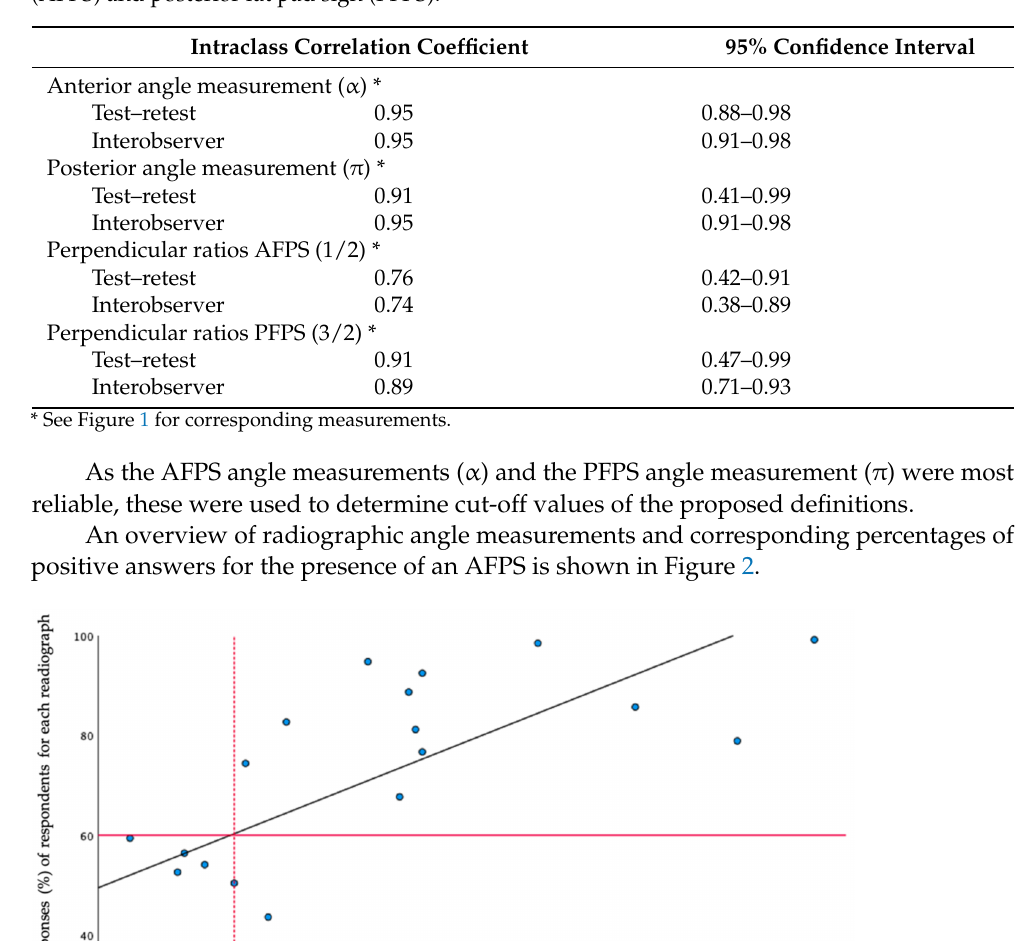
Table 3. Intraclass correlation coefficients (ICCs) for radiographic measurements of the anterior (AFPS) and posterior fat pad sign (PFPS).